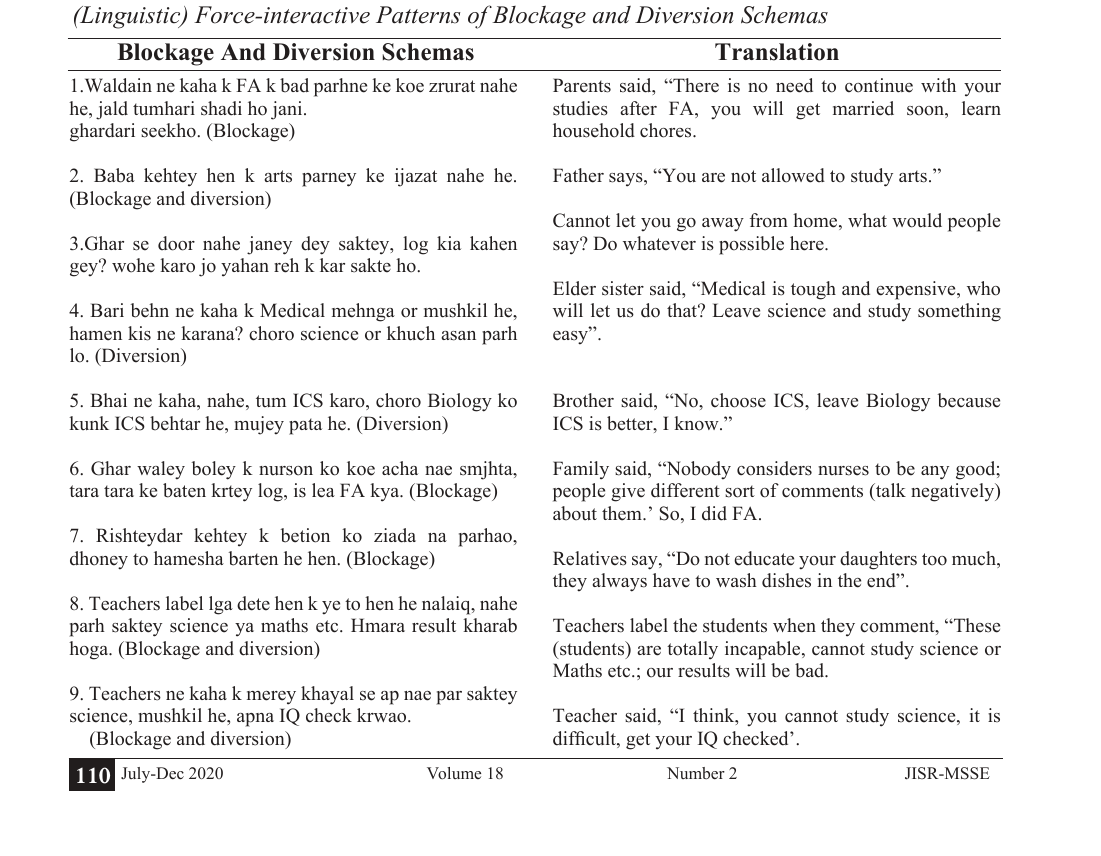
Blockage And Diversion